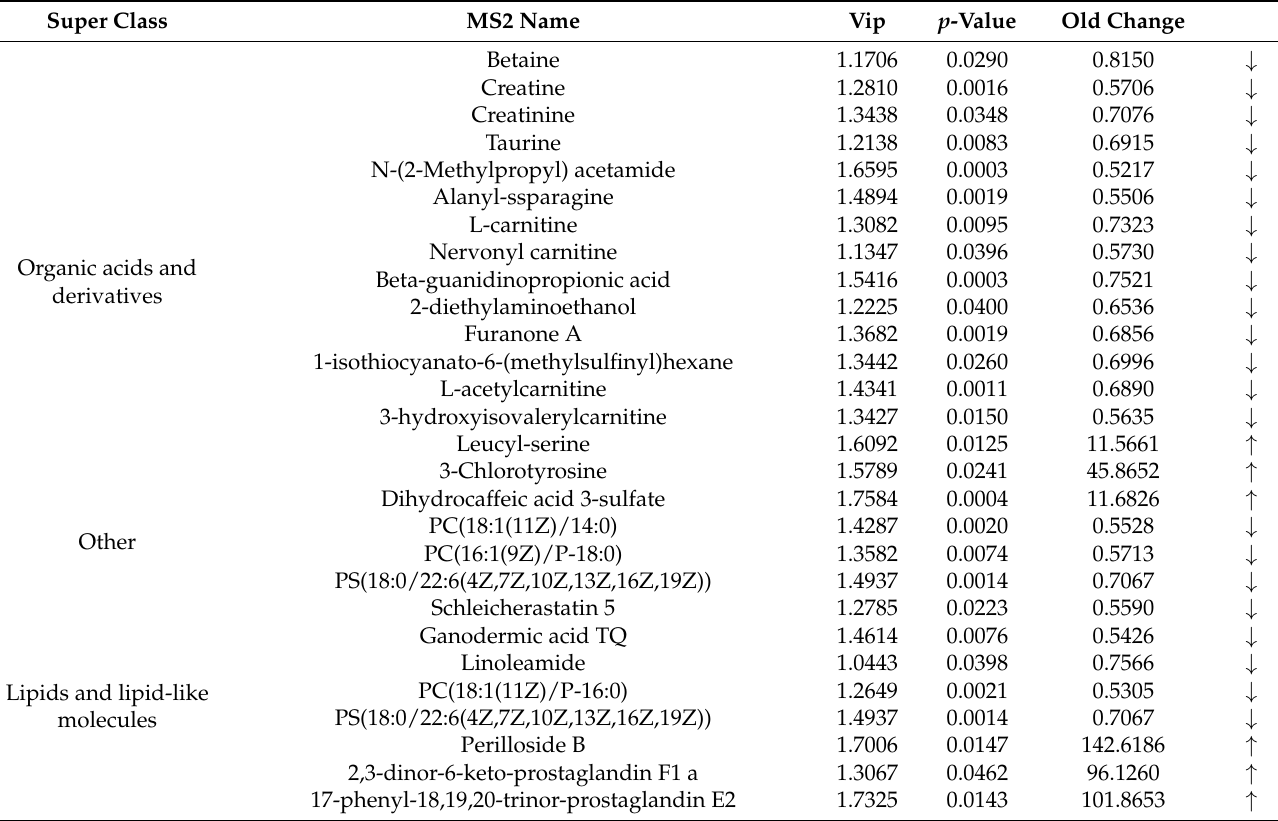
Figure 4. ( A ) Different metabolites under positive ion mode (NEG). ( B ) Different metabolites under negative ion mode (POS). The size of the dot represents the value of LOG_FOLDCHANGE; the smaller the dot, the smaller the corresponding LOG_FOLDCHANGE value. The color of the dot represents the classification of the different metabolite sources in the group and the line represents the correlation coefficient value of the metabolite at the corresponding location. Table 2. The difference in metabolites in the positive ion